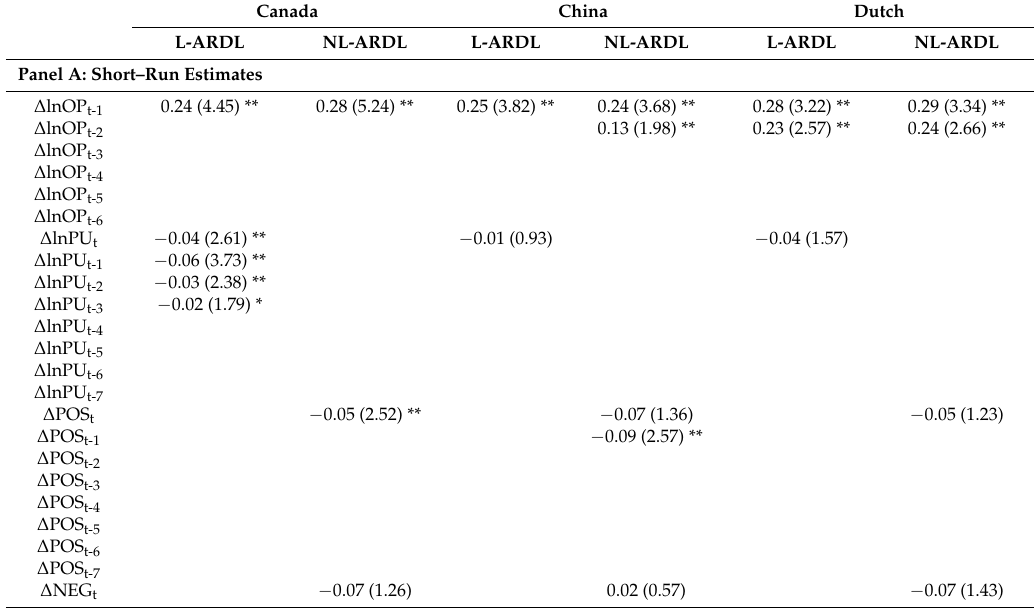
Table 1. Full-Information Estimates of Both Linear ARDL (L-ARDL) and Nonlinear ARDL (NL-ARDL) Models. Wald statics are both distributed as χ 2 with one degree of freedom. Canada China Dutch L-ARDL NL-ARDL L-ARDL NL-ARDL L-ARDL